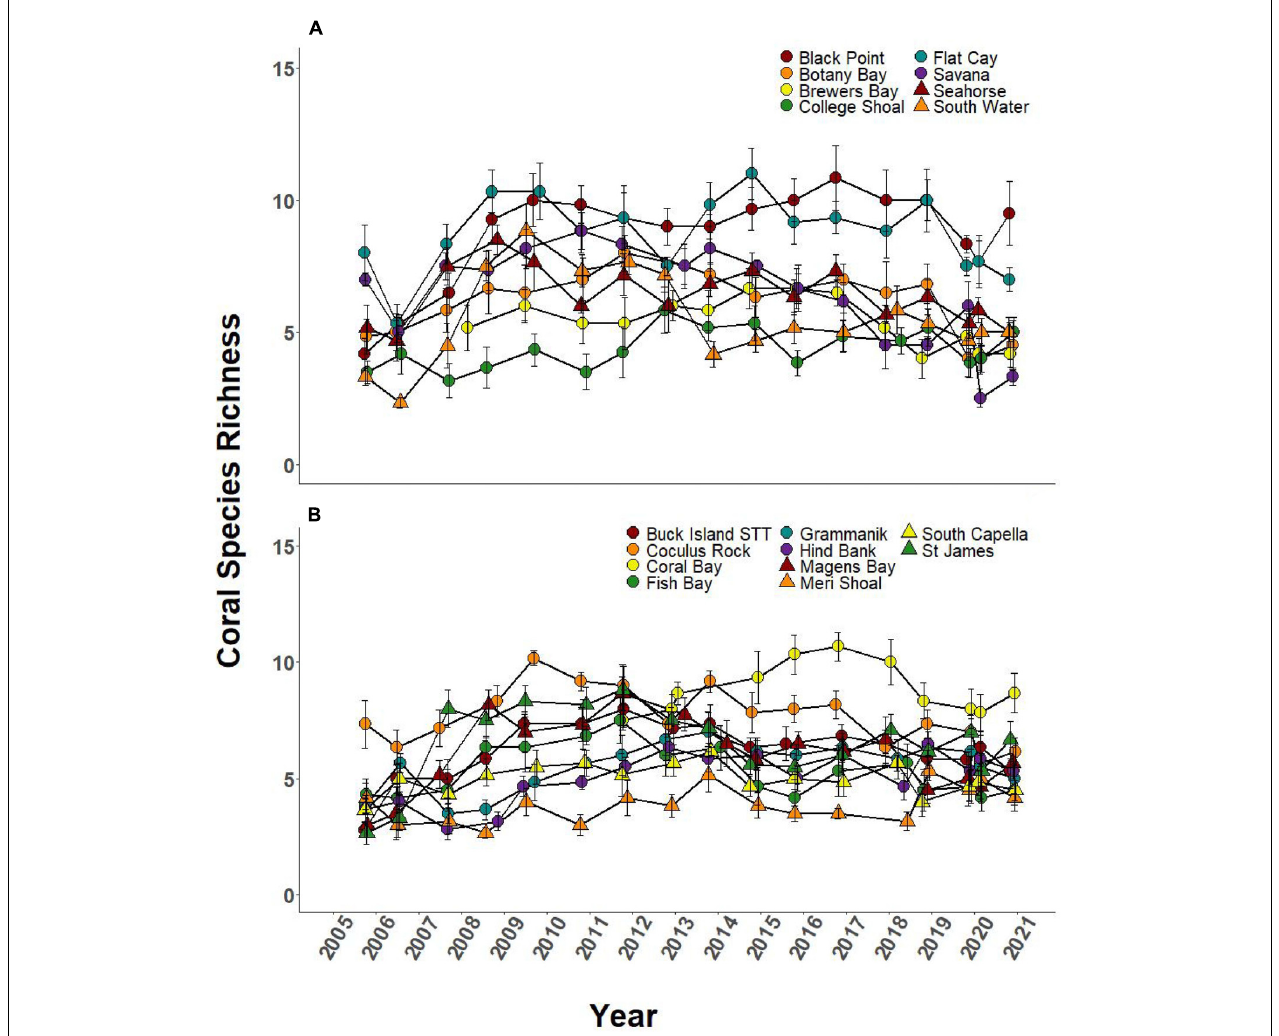
FIGURE 7 | Species richness of coral community ( ± SEM) at northern USVI TCRMP locations from 2005 to 2019. (A) Locations with SCTLD present; (B) Locations with no SCTLD present as of December